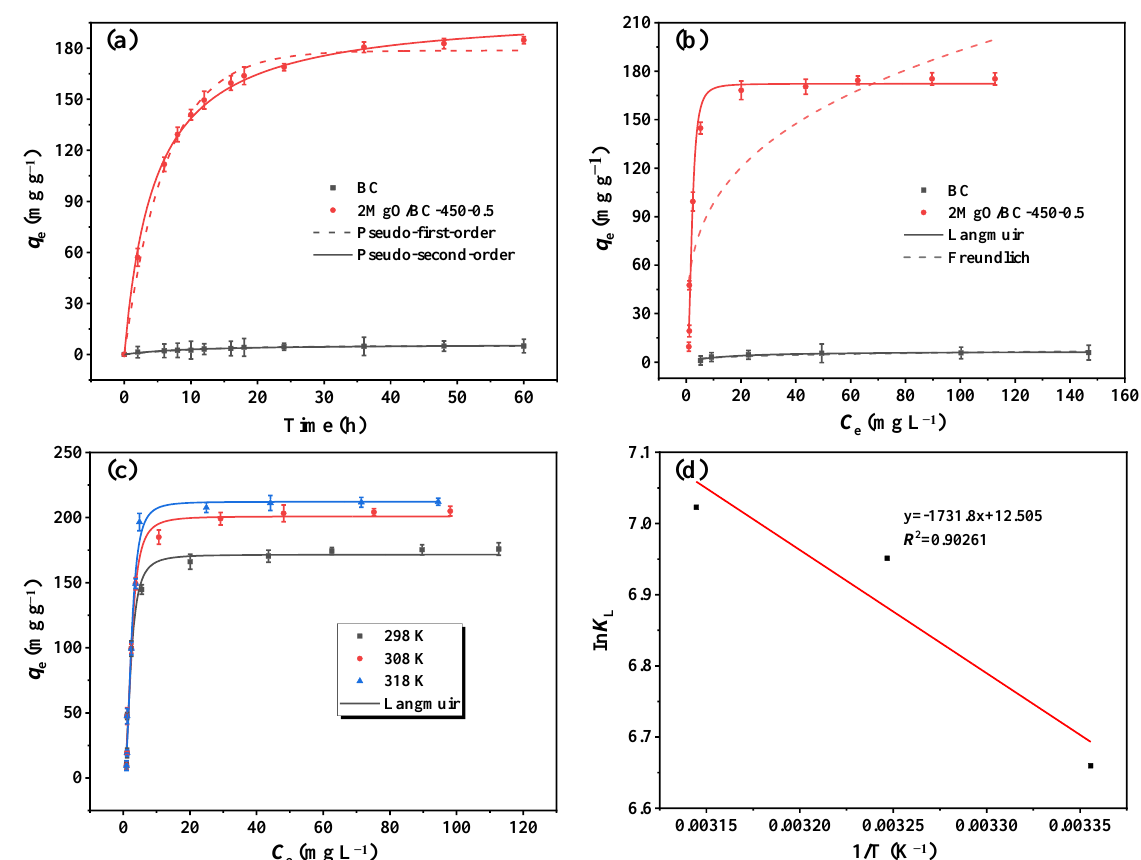
Figure 2. Adsorption kinetics ( a ) and isotherms ( b ) of phosphorus on BC and 2MgO/BC-450-0.5. Adsorption thermodynamics ( c ) and Va not Hoff plot ( d ) of phosphorus on 2MgO/BC-450-0.5. The adsorption isotherms of biochars were fitted with Freundlich and Langmuir Table 2. The maximum phosphorus adsorption capacity of different adsorbents at room tempera- models (Figure 2b). Compared with the Freundlich model ( R 2 = 0.762), the Langmuir ture from existing literature and in this work. model ( R 2 = 0.982) fitted the adsorption data better, suggesting that phosphorus adsorption on the surface of 2MgO/BC-450-0.5 was a monolayer adsorption process [48]. The obtained q max on 2MgO/BC-450-0.5 based on the Langmuir model were 171.54 mg g − 1 , which was almost 27-times that of BC. The q max of MgO-biochars for phosphorus adsorption surpassed most of MgO-modified materials and are comparable with some CaO-modified materials (Table 2). On the basis of MgO content (46.03%) and phosphorus adsorption capacity ( q max = 171.54 mg g − 1 ), the mole ratio of MgO to phosphorus was 2:1, considering that only the surficial atoms of MgO particles were available for the adsorbate. The adsorption thermodynamics of phosphorus on 2MgO/BC-450-0.5 were conducted increased from 171.54 to 212.19 mg g − 1 . According to the literature [49], the values of ∆ G 0 ,